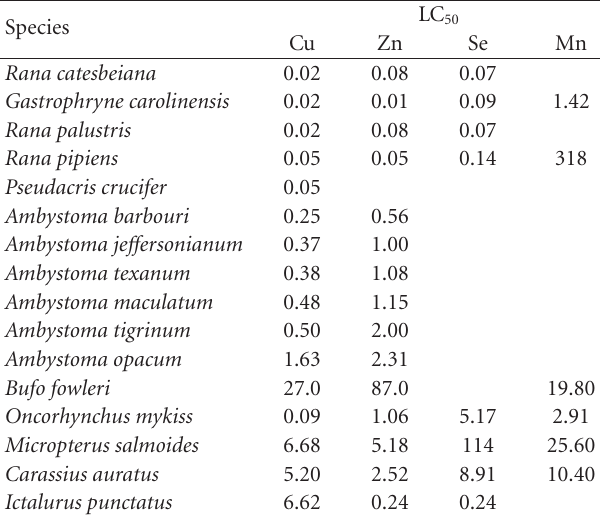
Table 3: 96 h lethal concentration in the 50% of the cases (LC 50 , mg/L) for early-life-stage amphibians and fish exposed to copper (Cu), zinc (Zn), selenium (Se) and manganese (Mn). (Source: